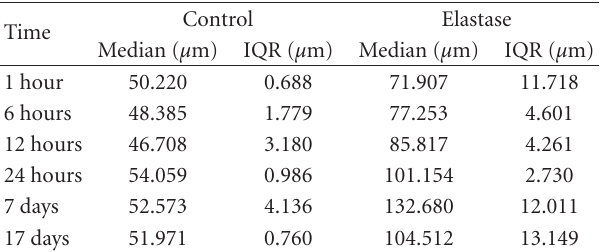
Table 4: Evolution of D 1 at the experiment time points after elastase aspiration.